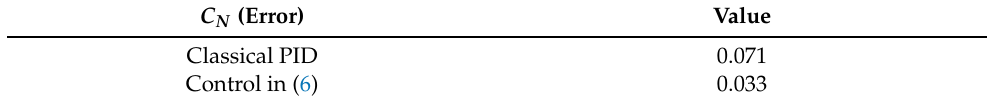
Table 3. Statistical mean absolute error corresponding to the control in the MagLev.